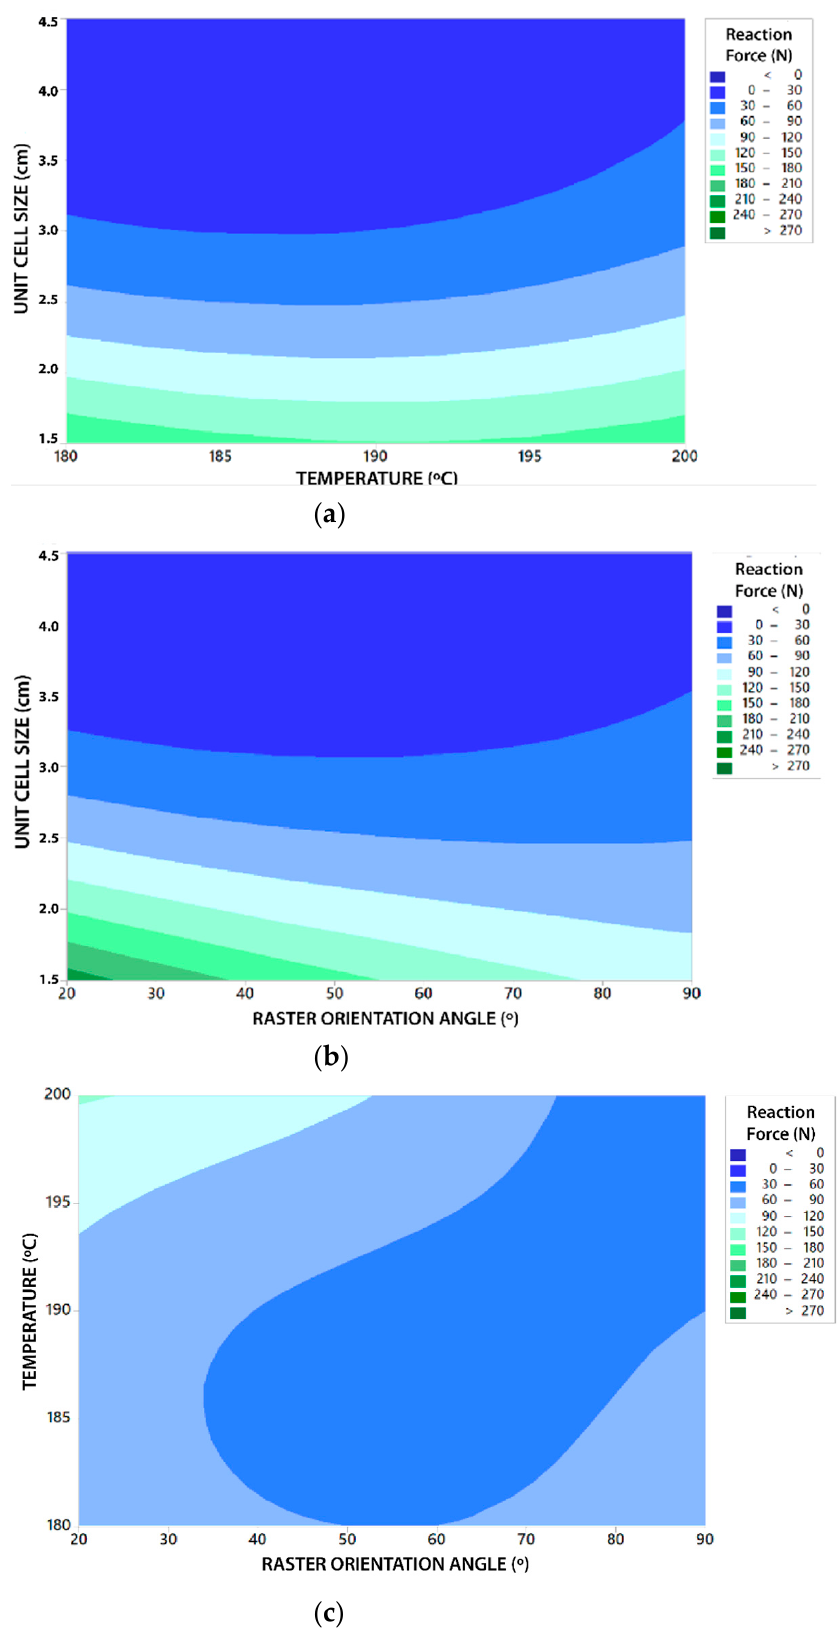
Figure C3. FCC contour plot; ( a ) Unit cell size (U) vs. Temperature (T); ( b ) Unit cell size (U) vs. Raster Orientation Angle (R); ( c ) Temperature (T) vs. Raster Orientation Angle (R).